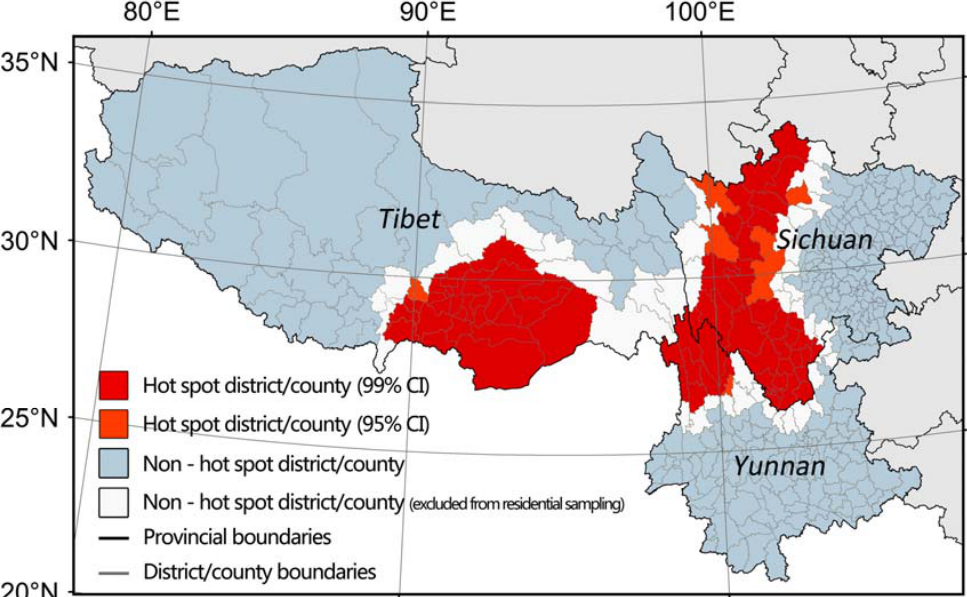
Figure 1. Distribution of hotspot districts/counties in southwest China from 2005 to 2014. (The white counties are indicated because they were excluded from residential sampling due to their uncertain status according to the hot spot analysis algorithm).